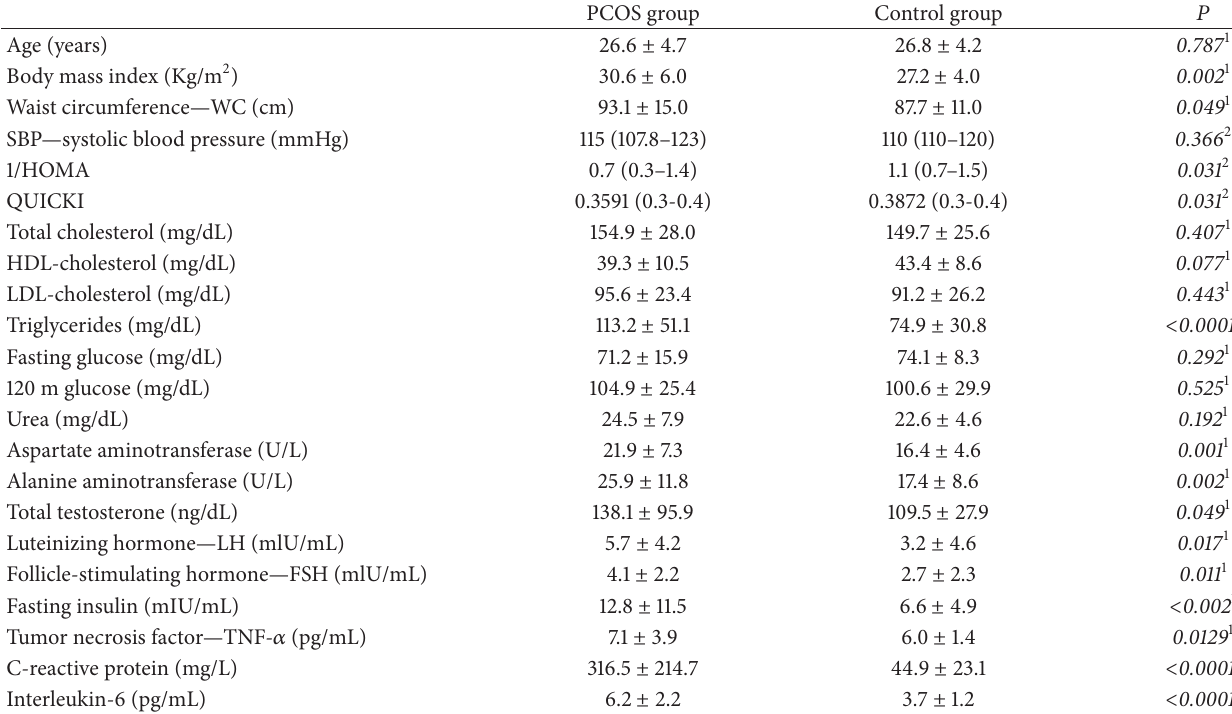
Table 1: Comparison of clinical, anthropometric, biochemical, hormonal, and inflammatory characteristics between PCOS and control groups.